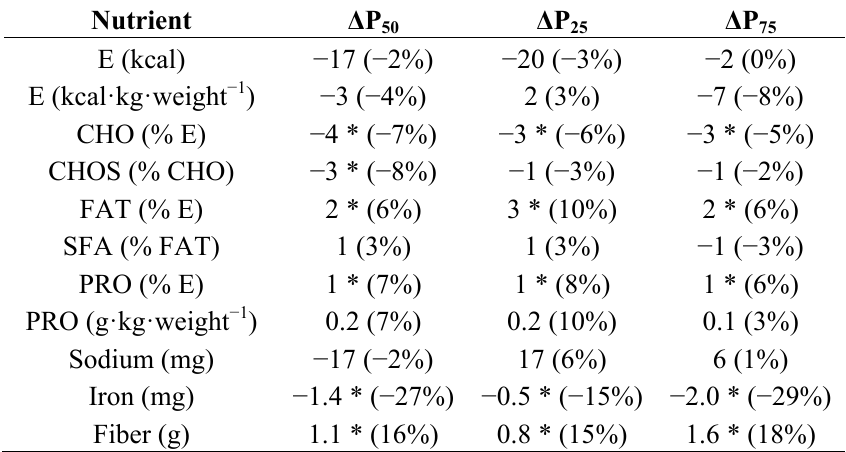
Table 2. Difference in daily energy and nutrient intake between Milano and Catania.